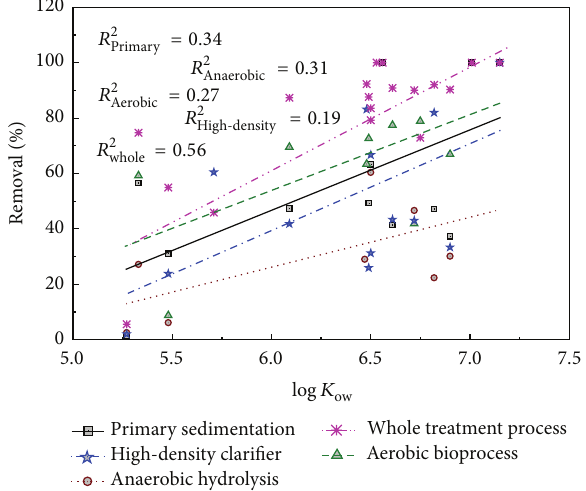
Figure 5: Percent removal of individual PCBs versus log 𝐾 treatment